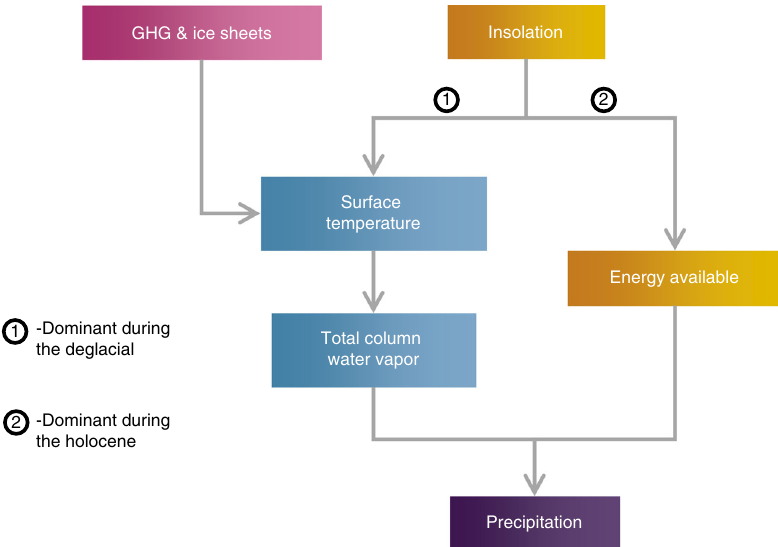
Fig. 4 A schematic of the mechanism. The fl owchart depicting the mechanism for the Indian monsoon, unraveled by the diagnostic method employed in this study. Insolation in fl uences monsoon by altering both the surface temperature and the local energy available in a column of the atmosphere. The former pathway is dominant during the deglacial period and the latter during the Holocene. The net energy also captures contributions from changes in clouds and therefore represents cloud radiative feedbacks. An indirect effect resulting from changes in surface temperature (TS) ampli fi es/dampens the solar forcing. Greenhouse gases and ice sheets modulate CWV by affecting the TS.